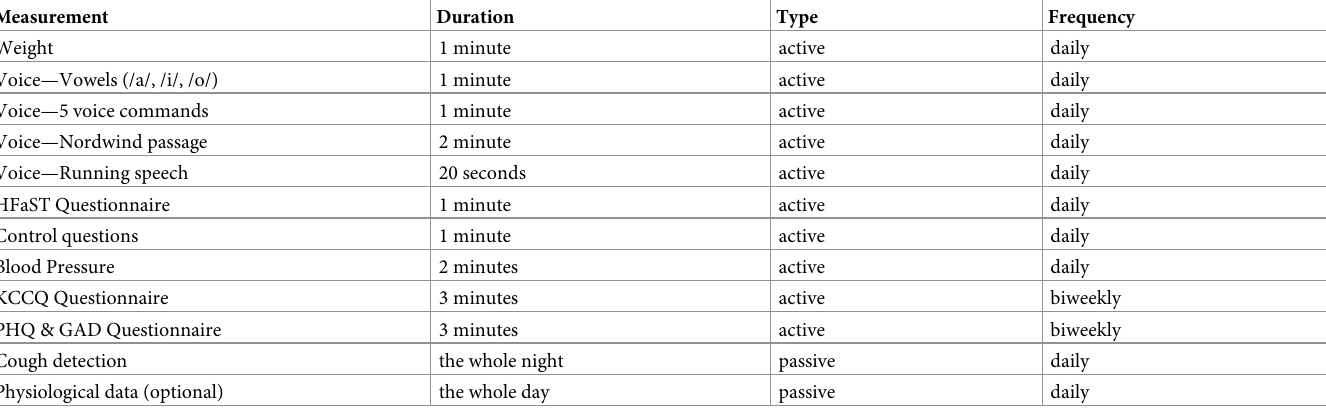
Table 3. Duration of the daily and weekly, active and passive